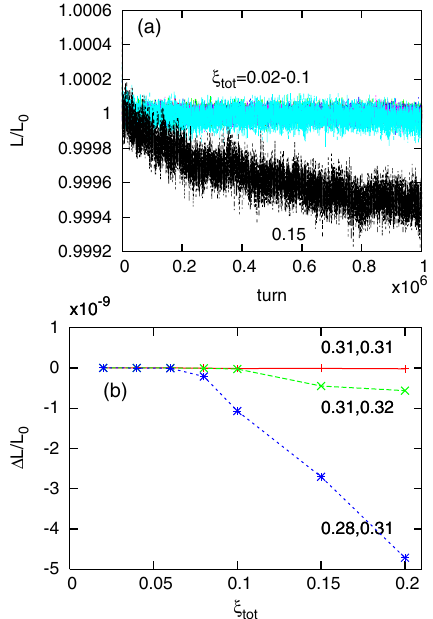
FIG. 1. Luminosity decrement obtained from the simple model consisting of the round beam interaction Eq. (4) and a linear arc. Picture (a) shows the luminosity evolution over 10 6 turns for various values of ξ at ð ν x ; ν y Þ ¼ ð 0 . 31 ; 0 . 32 Þ . Picture (b) sum- tot marizes the luminosity decrement per turn as a function of the total beam-beam parameter ξ at three different working points tot in the tune